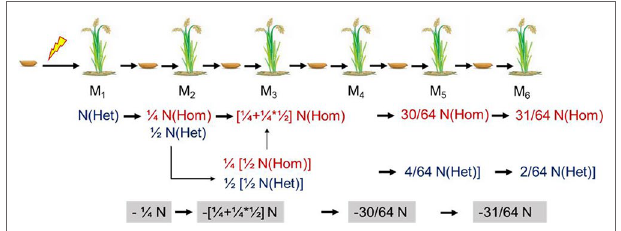
FIGURe 7 | Theoretical genetic model of mutations in self-pollinated offspring. Het, heterozygous; Hom,